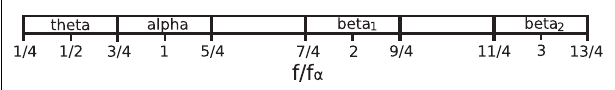
FIGURE 13 | Proposed band limits based on the frequency of the alpha